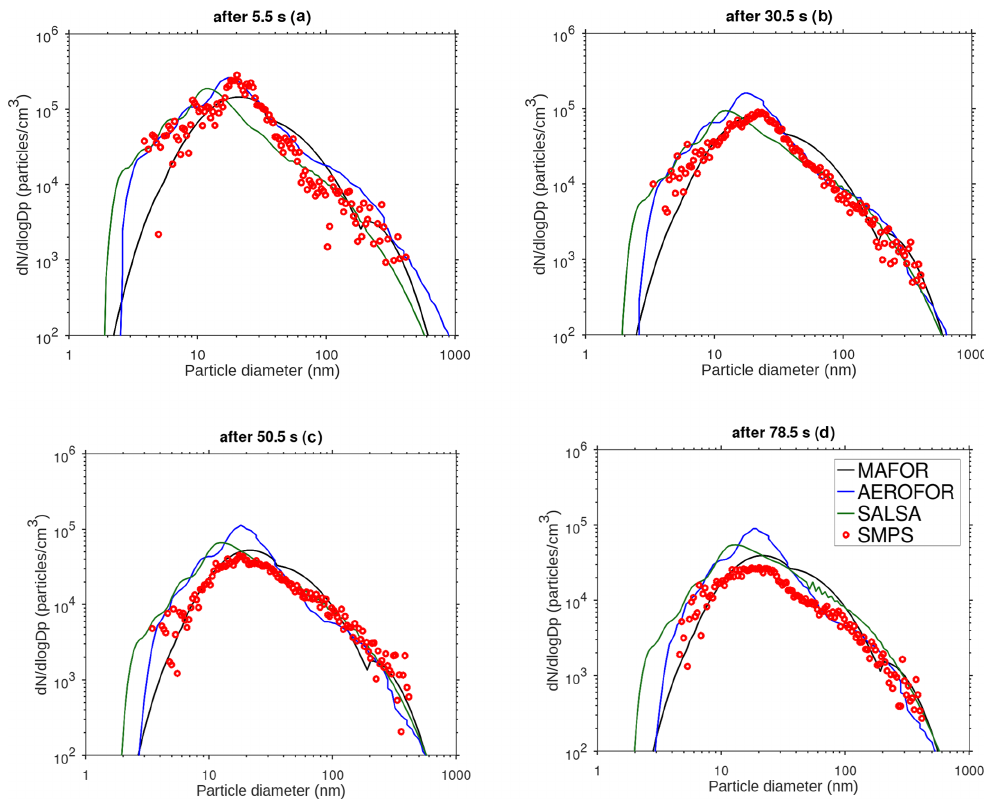
Figure 11. Comparison of particle number size distributions in the Urban Case scenario. Modelled size distributions from the aerosol dynamics models MAFOR, AEROFOR, and SALSA and measured size distributions from SMPS are shown at location points A, B, C, and D. Table 7. Statistical performance indicators for the comparison of modelled and measured number size distributions for each location point A, B, C, and D as well as the average performance (mean IOA and mean COE). MAE is given in particlescm − 3